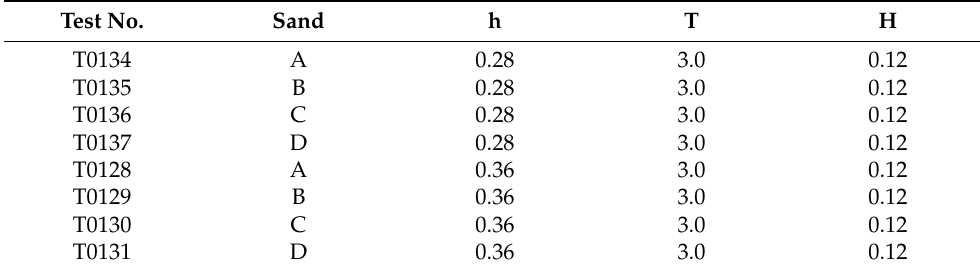
Table 2. Summary of PIV wave test cases. Test